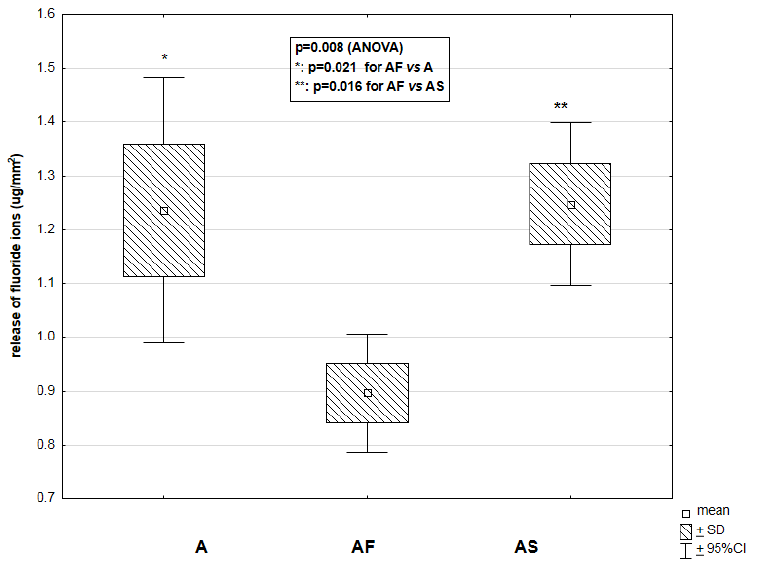
Figure 5. Relationship between the type of studied material (A—Admira ( n = 5); AF—Admira Flow ( n = 5); AS—Admira Seal ( n = 5)) and the release of fluoride ions ( μ g/mm²) into deionized water in a period of 2352 h.